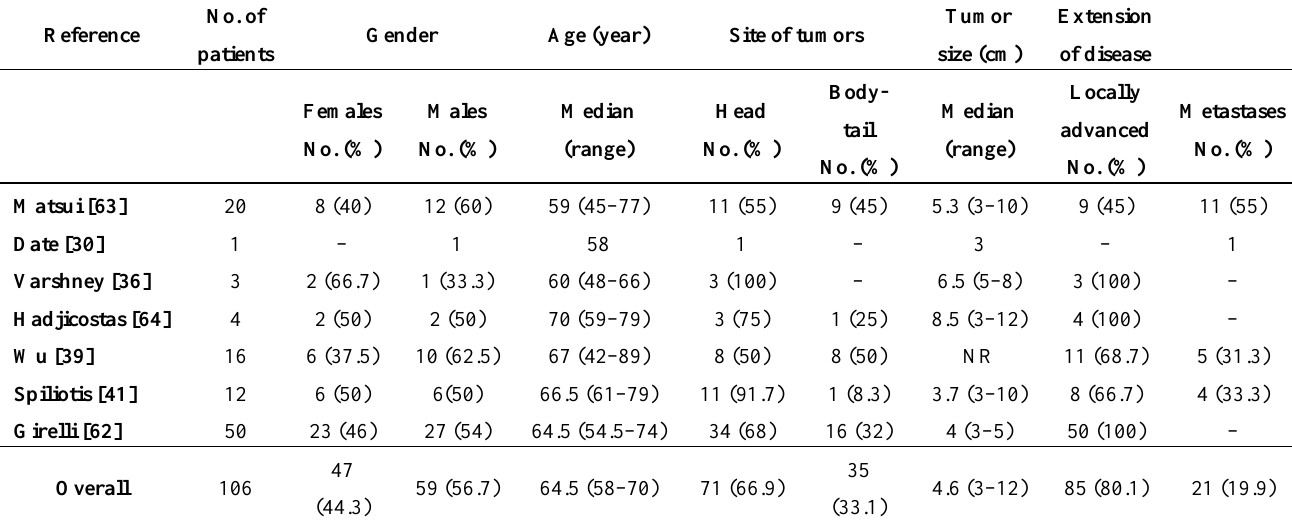
Table 1. Demographics and clinical data of 106 patients who underwent radiofrequency ablation for pancreatic ductal adenocarcinoma. Data are reported as absolute number, frequency, median and range. NR = not reported.